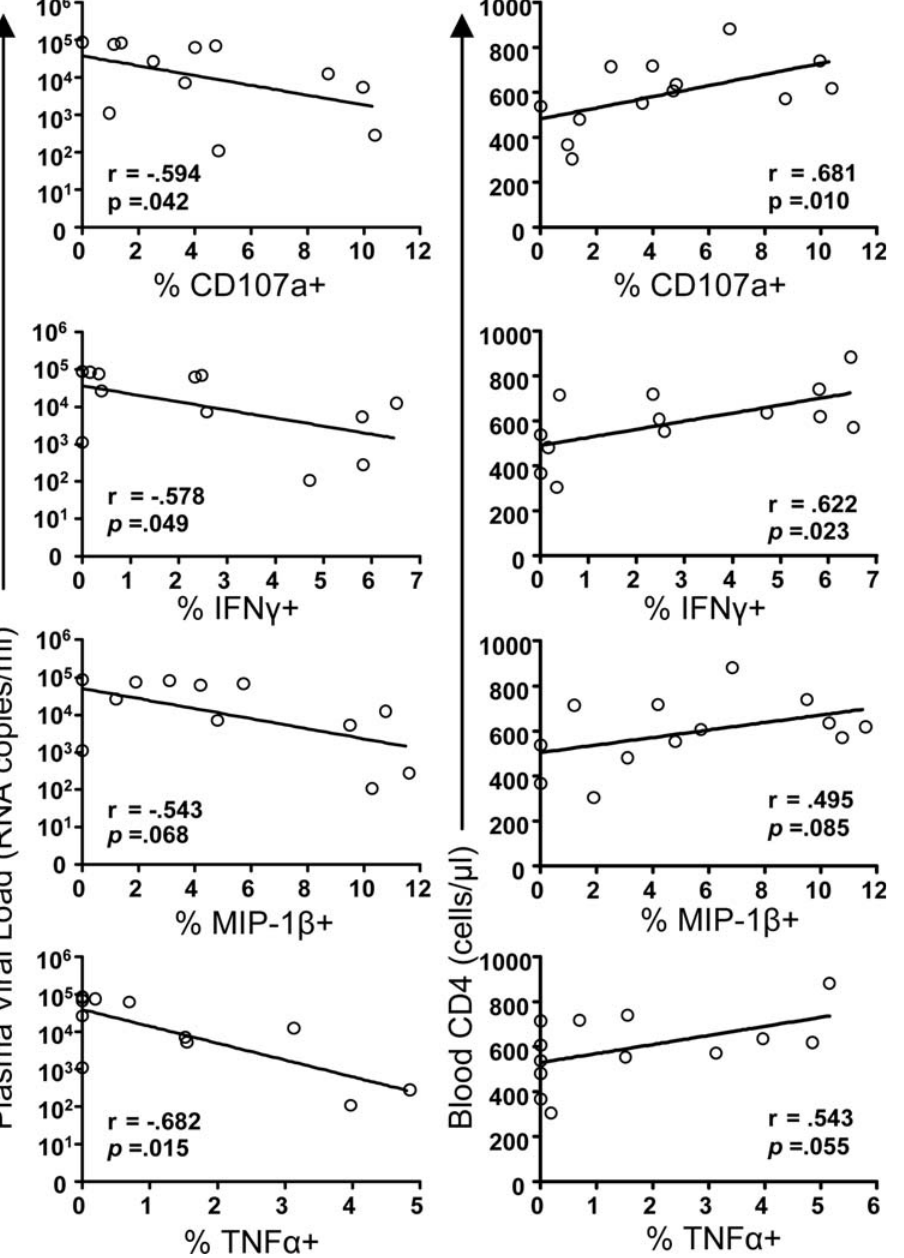
Figure 4. Correlation (Spearman) of rectal CD8 + T-cell responses to plasma viral load or blood CD4 count in patients not on ART. CD8 + T-cell responses (shown as percentages of cells producing cytokines/chemokines or CD107a, as in Fig. 3), were plotted against viral load and CD4 percentages. Results for Spearman r value and level of significance are shown. Lines represent best fits as estimated by linear regression. Comparable relationships between PBMC functional responses and clinical parameters are not shown, as none were statistically